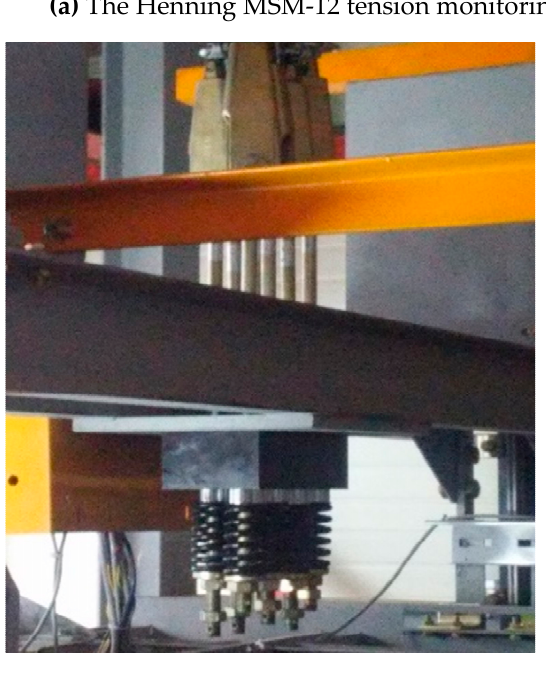
Figure 13. The test equipment and field installation used for the performance test.